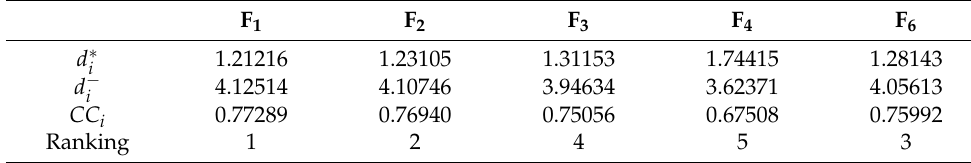
Table 21. The CC i of the five factors.